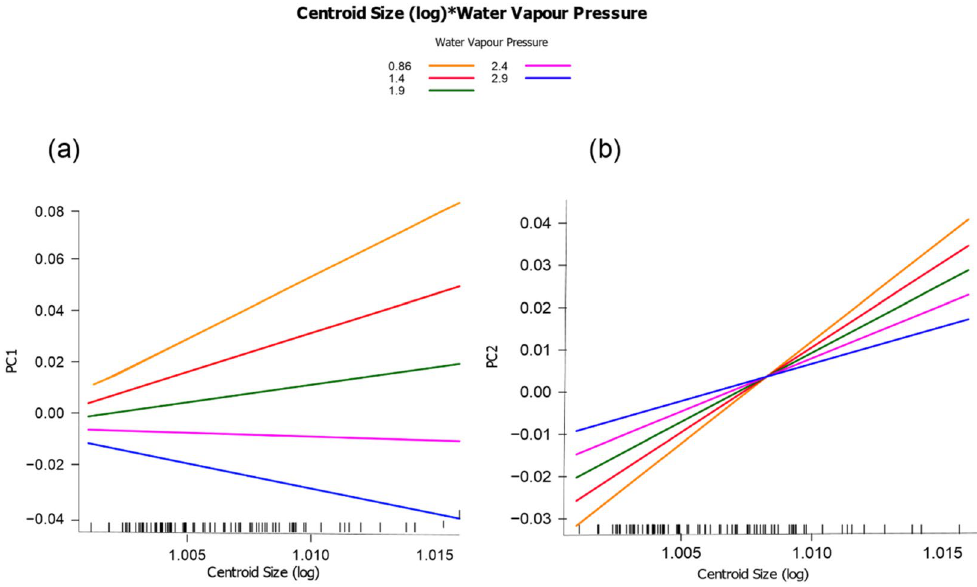
Figure 3. Phylogenetic regression between log-transformed centroid size (Cs) and principal components (PC1 and PC2) of the shape of Arboranae species across a water stress gradient. ( a ) Relationship between Cs and PC1; ( b ) relationship between Cs and PC2. Colour scale varies from dry (orange) to more humid (blue) environments. The bars on the x-axis are sampled data